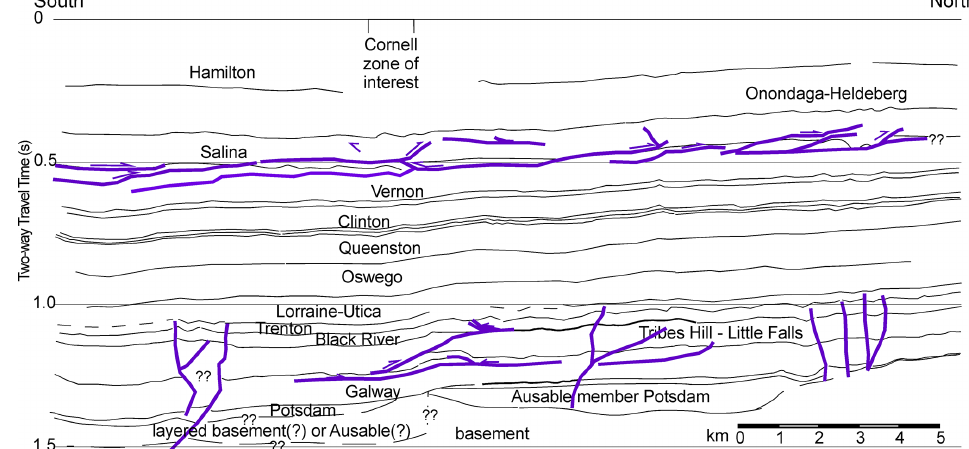
Figure 3. Line drawing of an interpreted seismic reflection profile (location in Fig. 1) which traverses a short distance east of Cornell’s targeted geothermal well field area of interest. Black thin lines are stratigraphic contacts within the sedimentary rock column. Purple thick lines are faults. Near 0.5s TWTT, the set of faults are thrusts within the weak series of Silurian mudstones and evaporites. Between 1.0 and 1.5s TWTT the faults are of two classes. The small-offset sub-vertical sets are typical of the Trenton–Black River grabens, related to wrench faults. The sub-horizontal faults are small displacement thrusts. Both the shallow and deep thrusts likely were active during the Alleghanian Orogeny. Interpretation by Jordan